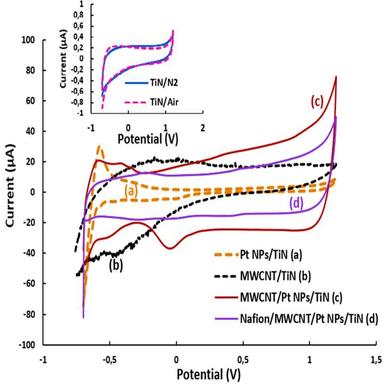
CV voltammograms of inset: both TiN/Air and TiN/N2 electrode, (a) Pt NPs/TiN electrode, (b) MWCNTs/TiN electrode, (c) MWCNTs/Pt NPs/TiN electrode, and (d) Nafion/MWCNTs/Pt NPs/TiN electrode in 50 mM PBS (pH = 7.4) in absence of dopamine.